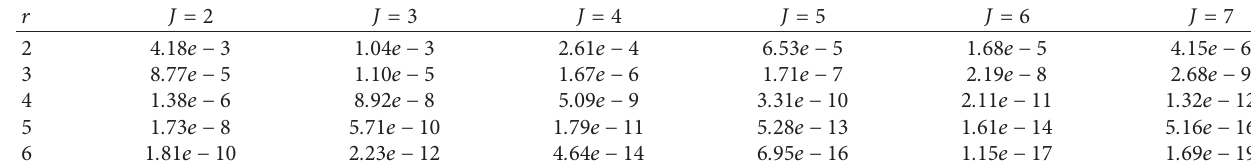
-error for Example 4. 2